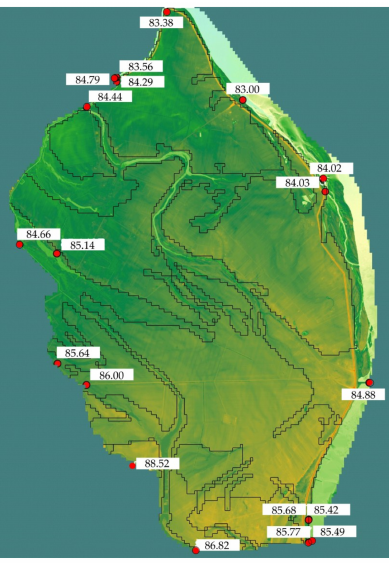
Figure 4. General view on the limits of erosional troughs in the study area; extracted from the Visual Modflow.